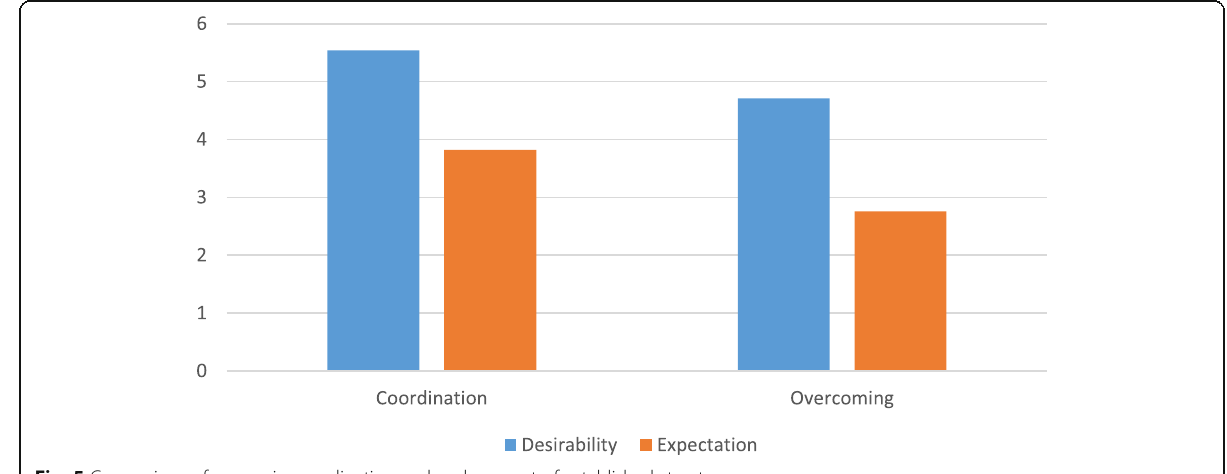
Fig. 5 Comparison of means in coordination and replacement of established